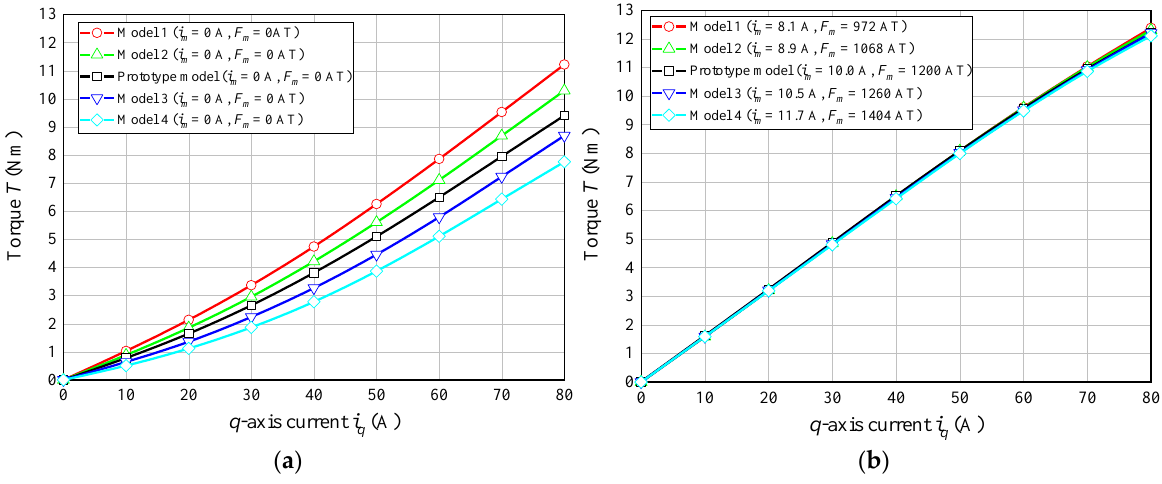
Figure 24. I–T characteristics of proposed motor models with different magnetic leakage path widths: ( a ) without F m ; ( b ) with F m